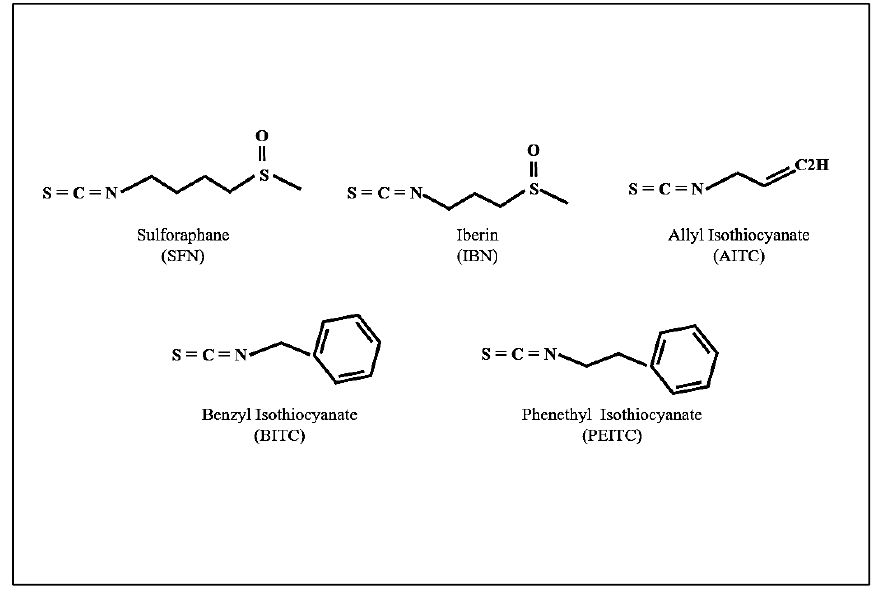
Figure 1. The s tructures of major isothiocyanates (ITCs). Figure 1. The structures of major isothiocyanates